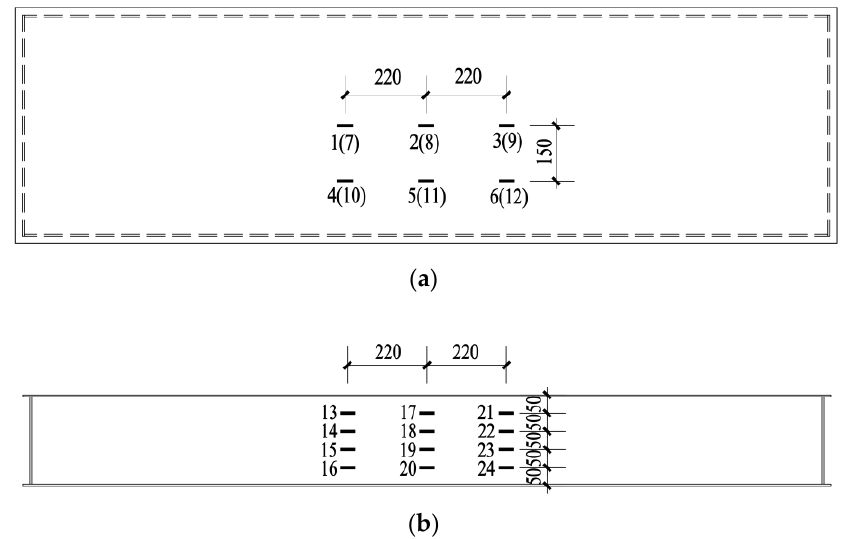
Figure 5. Arrangement of the strain gauges: ( a ) Layout of top (bottom) measuring points; ( b ) Measuring points layout on the side.